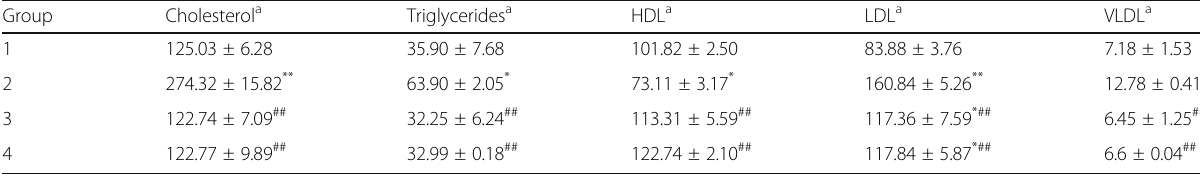
Table 4 Effects of HIE treatment on serum lipid profile in streptozotocin induced diabetic mice